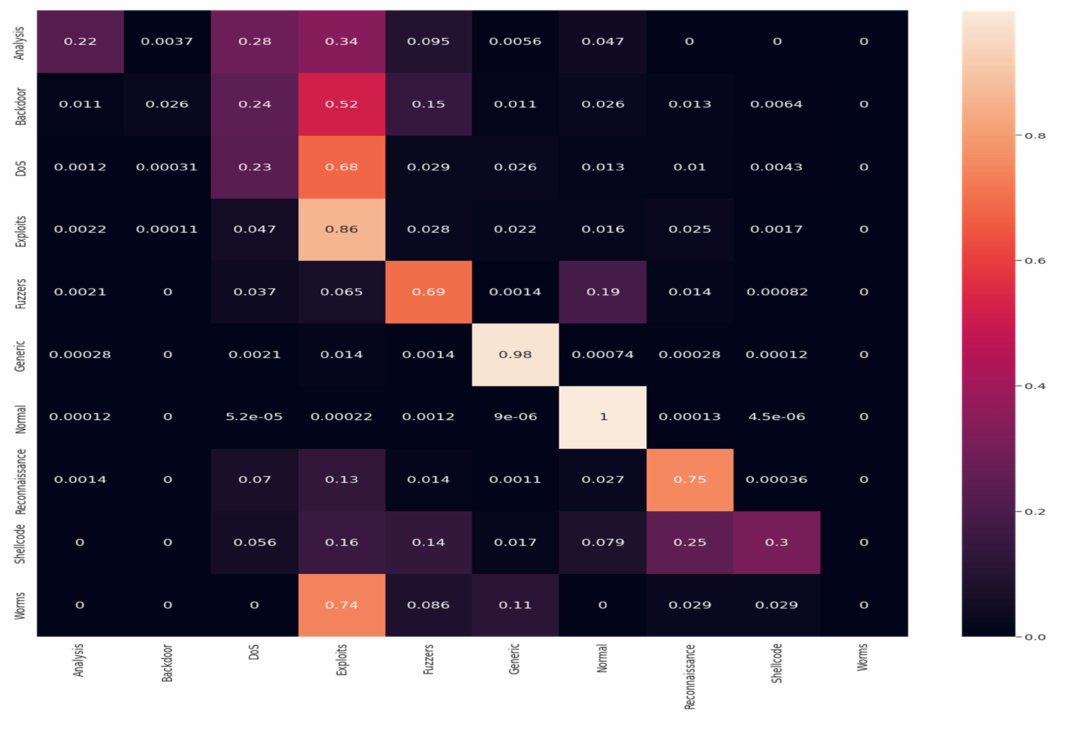
Figure 18. The confusion matrix for 10 classes in the Inception Time validation with a window size of six using the UNSW-NB15 dataset: normal, fuzzers, generic, exploits, reconnaissance, DoS, analysis, backdoor, worms, and shellcode; all values between 0.50 and 99.